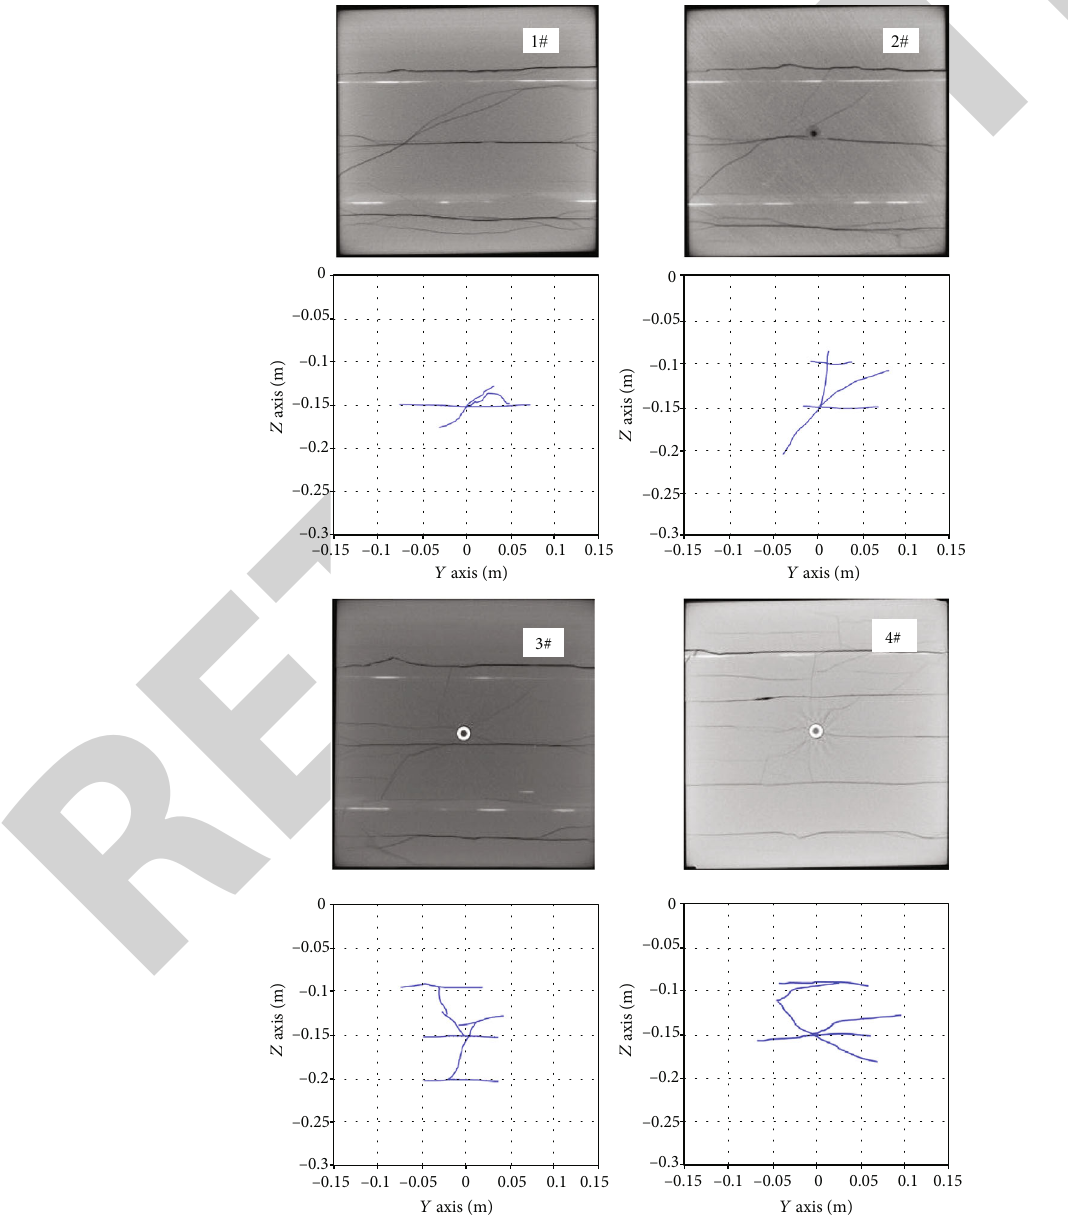
Figure 16: The explanation results of CT